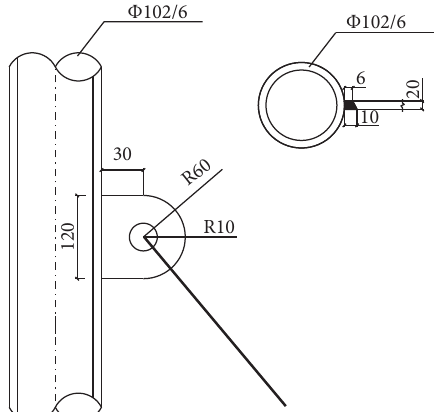
Figure 2: Schematic diagram of the welded joint.